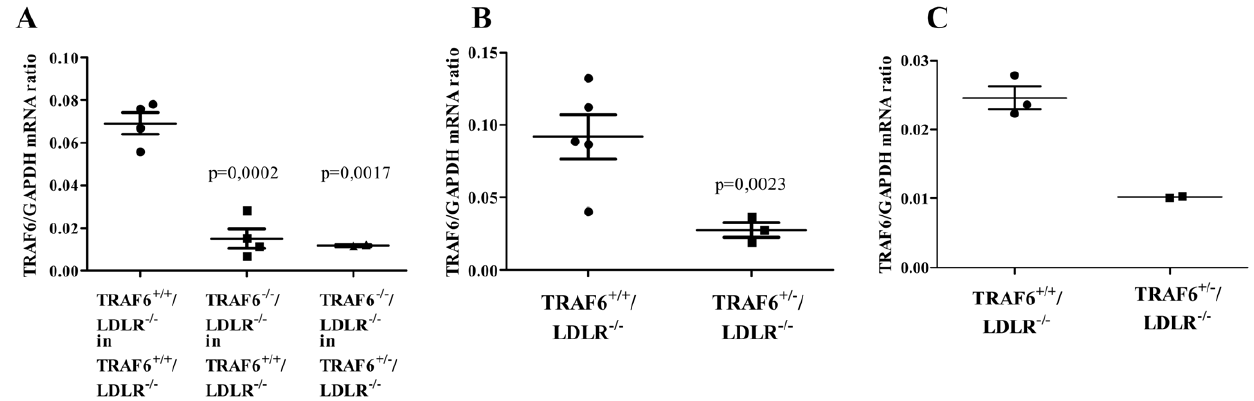
Figure 2. Mice reconstituted with TRAF6-deficient fetal liver cells and TRAF6 heterozygous mice express less TRAF6 than controls. Lethally irradiated 6 week old TRAF6 + / + /LDLR 2 / 2 mice received TRAF6-deficient (N=4) or competent fetal liver cells (N=4), TRAF6 + / 2 /LDLR 2 / 2 mice received TRAF6-deficient fetal liver cells (N=2) only. RNA was isolated from spleens. Ratios of TRAF6/GAPDH mRNA as assessed by quantitative RT- PCR are shown as mean 6 SEM (A). RNA was isolated from spleens (B) and aortas (C) of TRAF6 + / + /LDLR 2 / 2 (N=5 and 3) TRAF6 + / 2 /LDLR 2 / 2 mice (N=3 and 2). Ratios of TRAF6/GAPDH mRNA as assessed by quantitative RT-PCR are shown as mean 6 SEM.